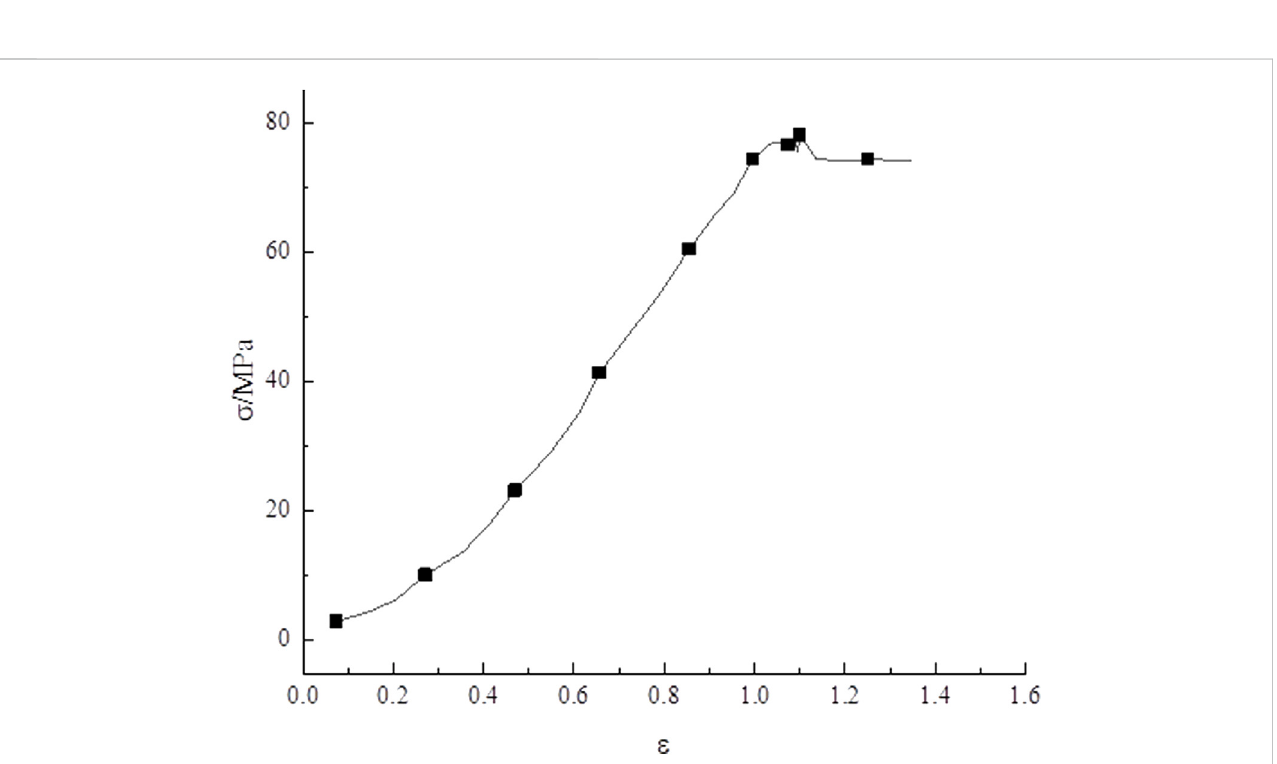
FIGURE 10 Elastic modulus and Poisson ’ s